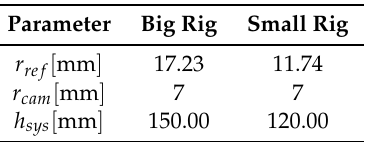
Table 2. By-product Length Parameters.